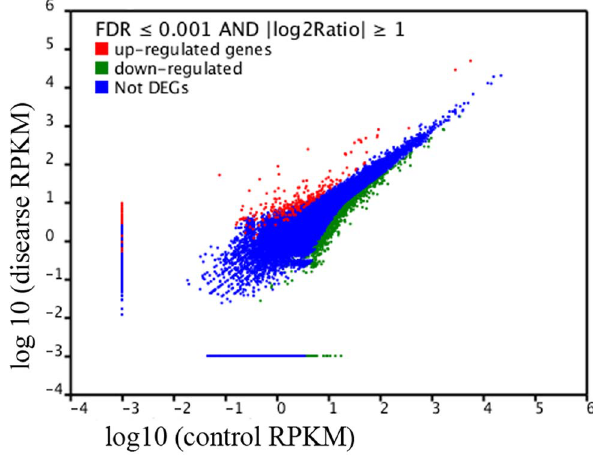
Figure 2. Comparison of unigene expression between the normal control (CK) and surface brown spots disease (SBS, dis) fruit. The abundance of each gene was normalized as Reads per kb per Million reads (RPKM). The differentially expressed genes are shown in red and green, while blue indicates genes that were not differentially expressed (not DEGs) between CK and